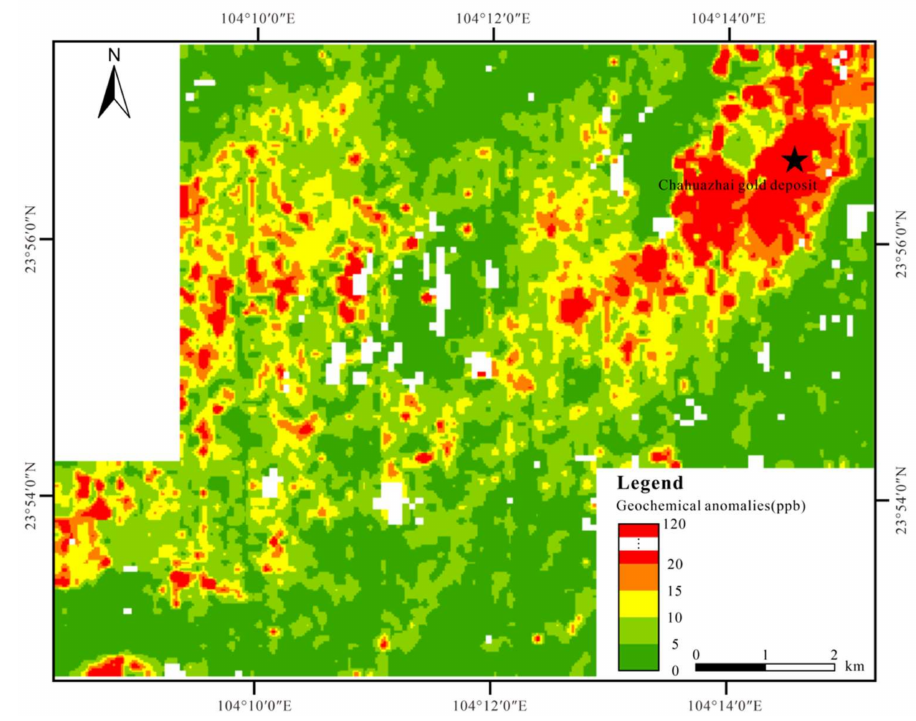
Figure 2. Au anomalies from samples in the study area.